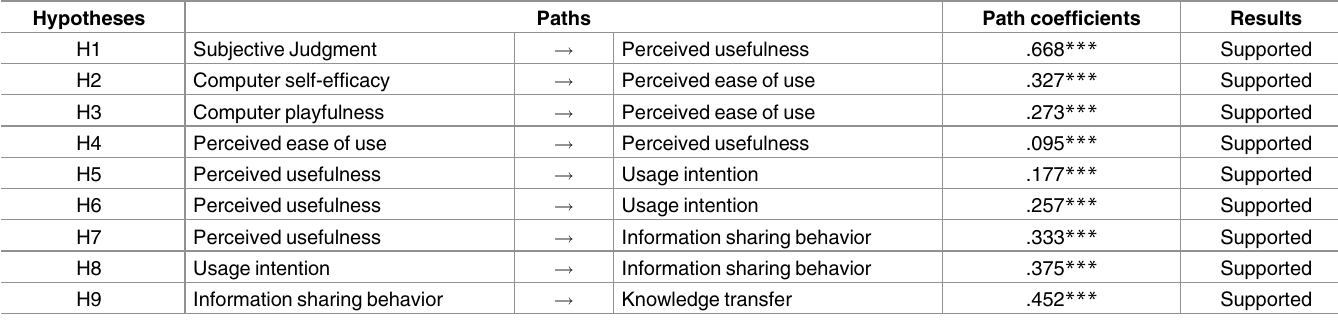
Table 9. Hypotheses test result